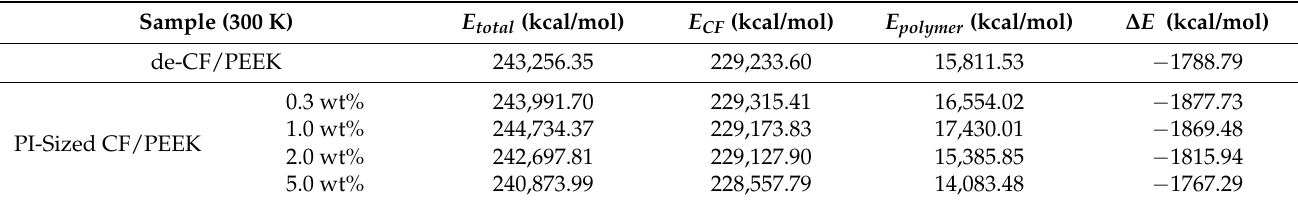
Table 1. Interaction energy of CF/PEEK composites using MD simulation.